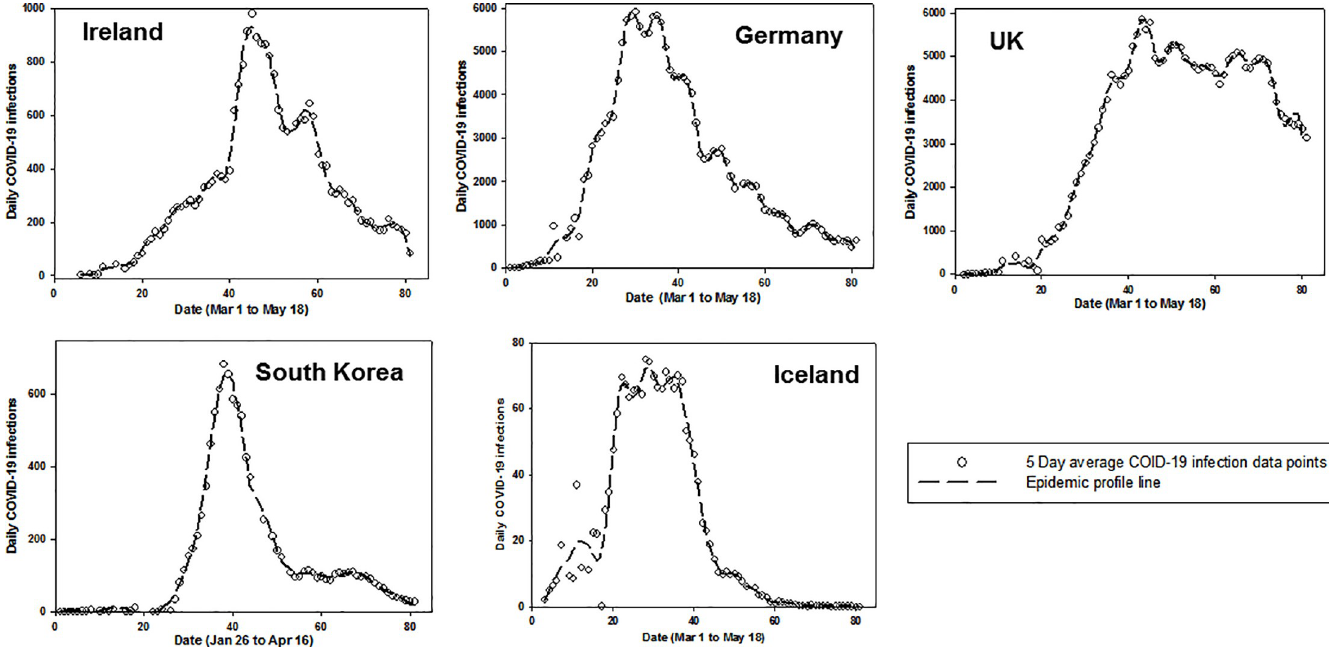
Fig 1. Epidemic profile lines for Ireland, Germany, UK, South Korea and Iceland. Plots of five-day averaged confirmed COVID-19 infections as a best-fit smooth epidemic profile line.